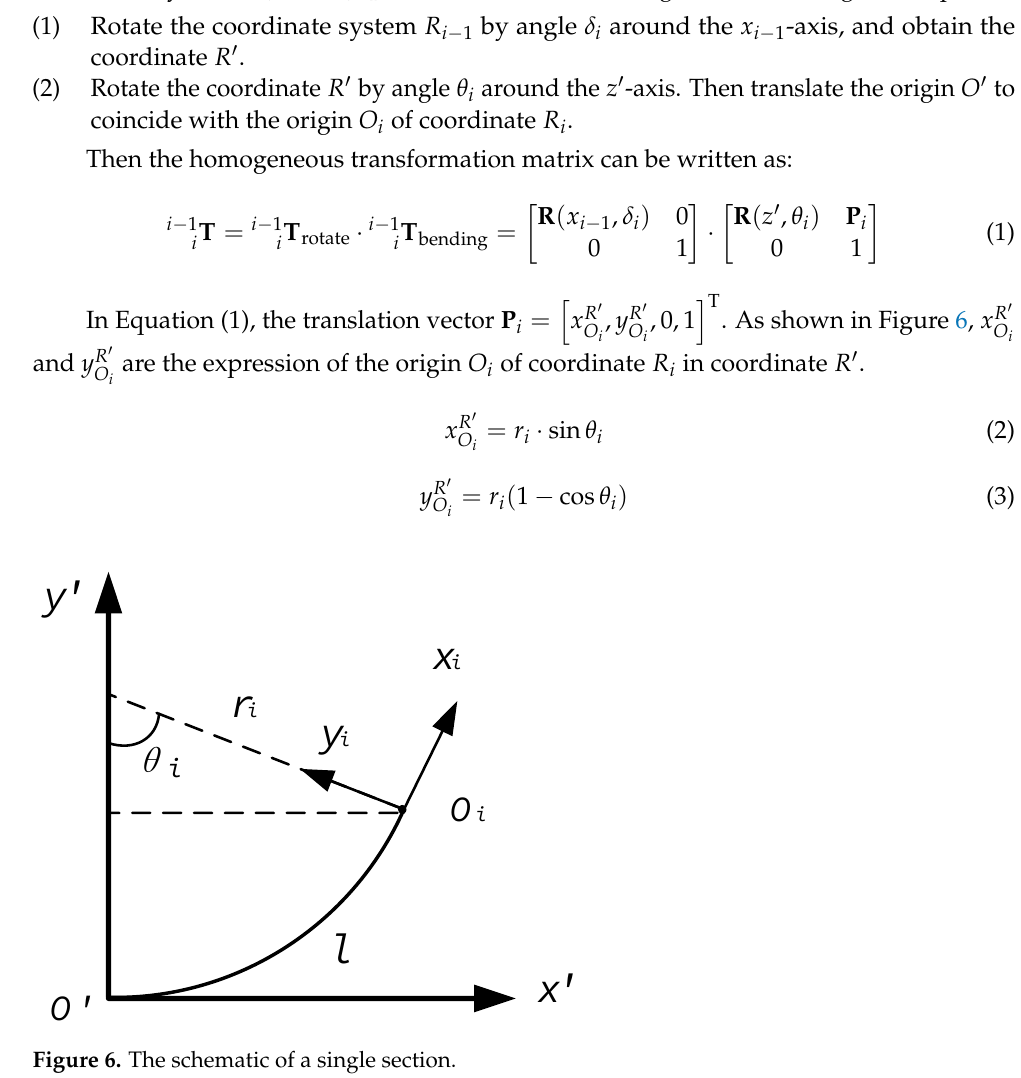
Figure 6. The schematic of a single section.